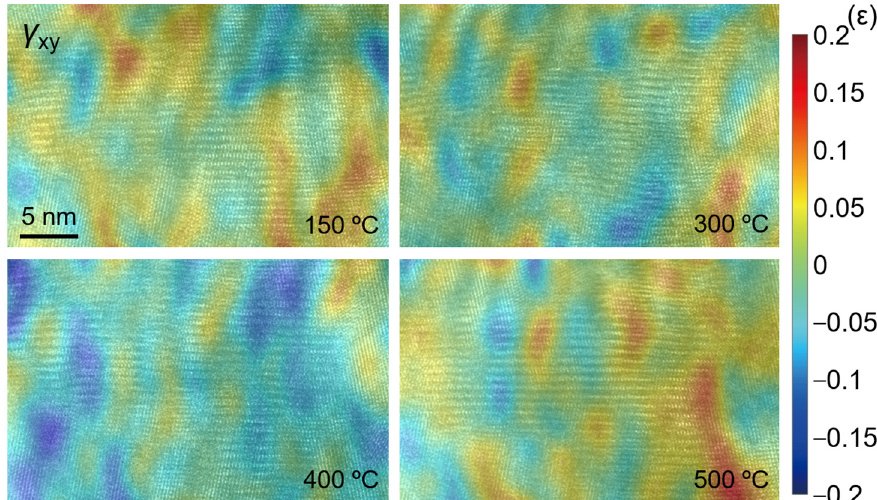
Figure 18. Calculated strain field ε xy . Table 4. The elastic constants of TGO in the